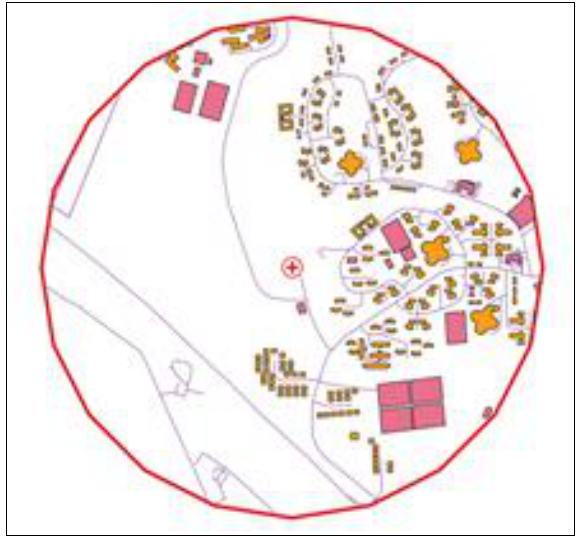
Figure 2. Example of buffer analysis (distance to UTM Health